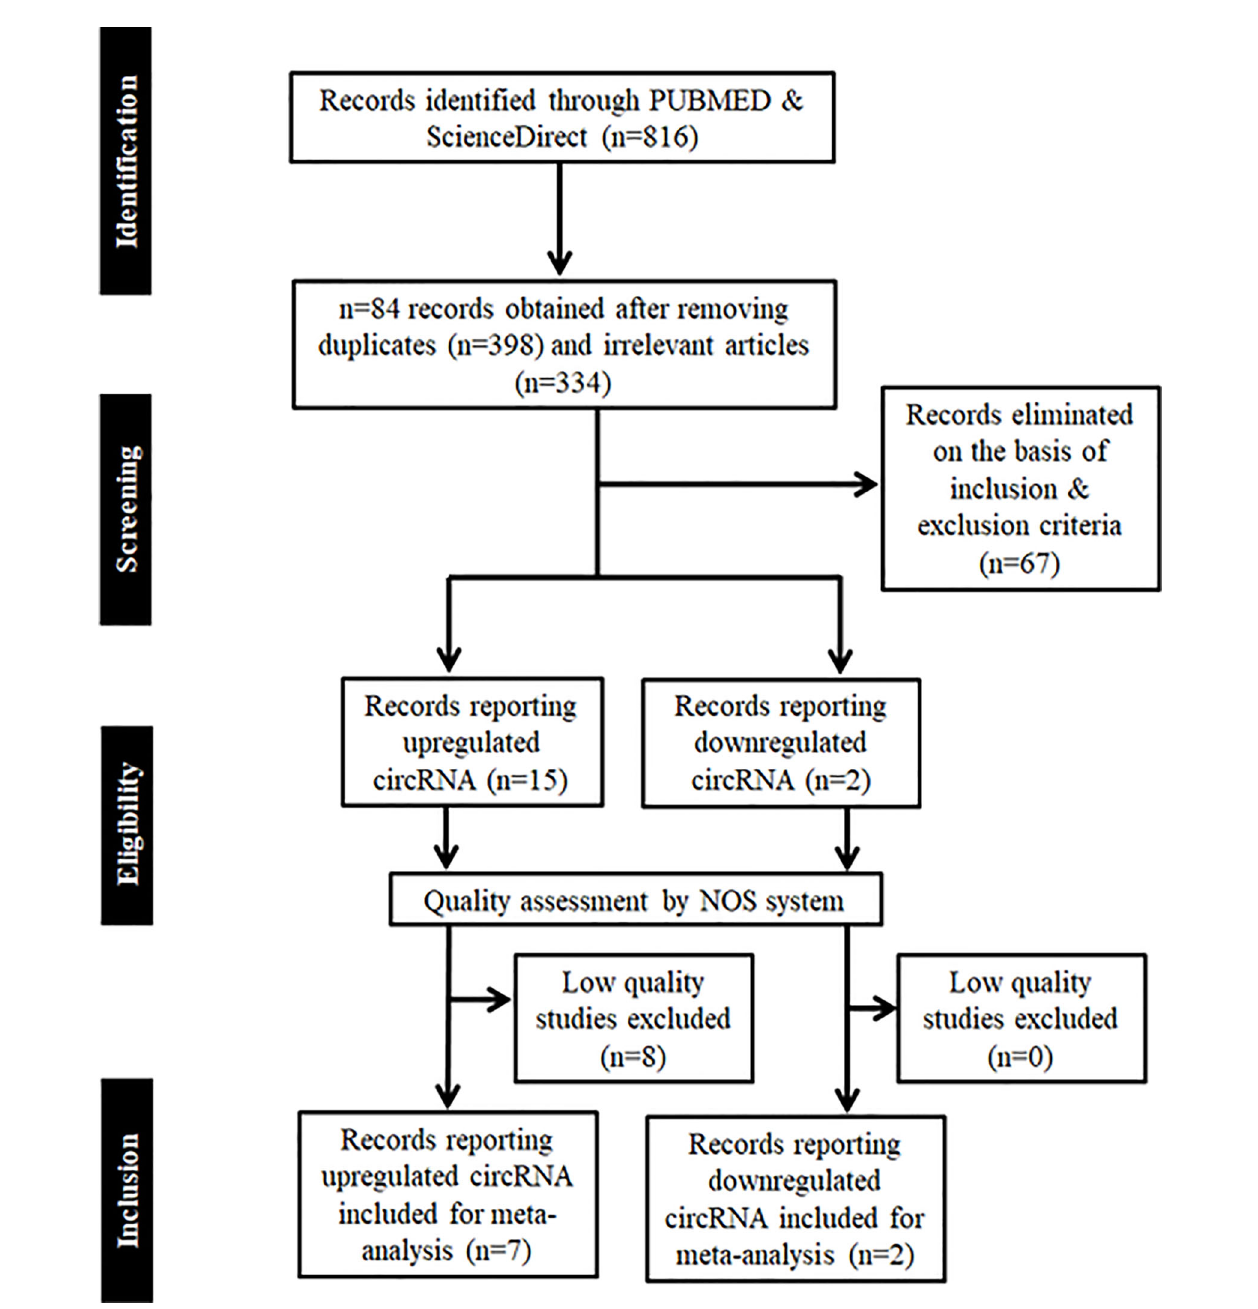
FIGURE 1 | PRISMA fl ow chart showing the methodology employed for literature retrieval for meta-analysis. Records were screened on the basis of inclusion and exclusion criteria, whose quality was further assessed by NOS